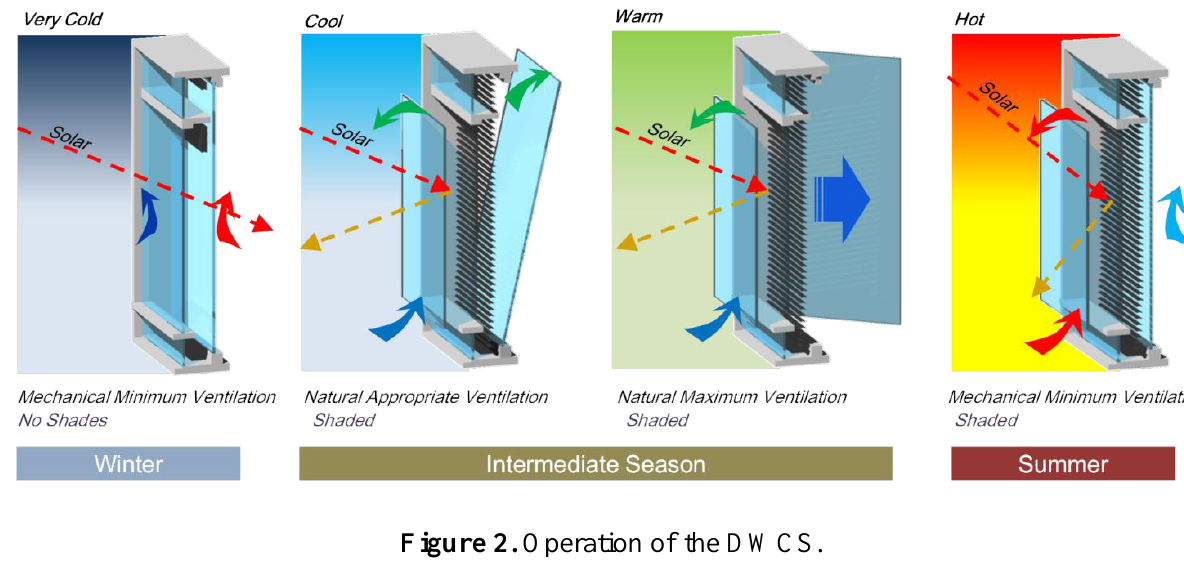
Figure 2. Operation of the